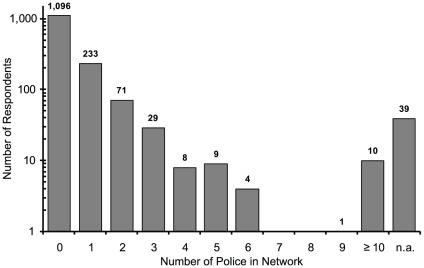
Police Officers.